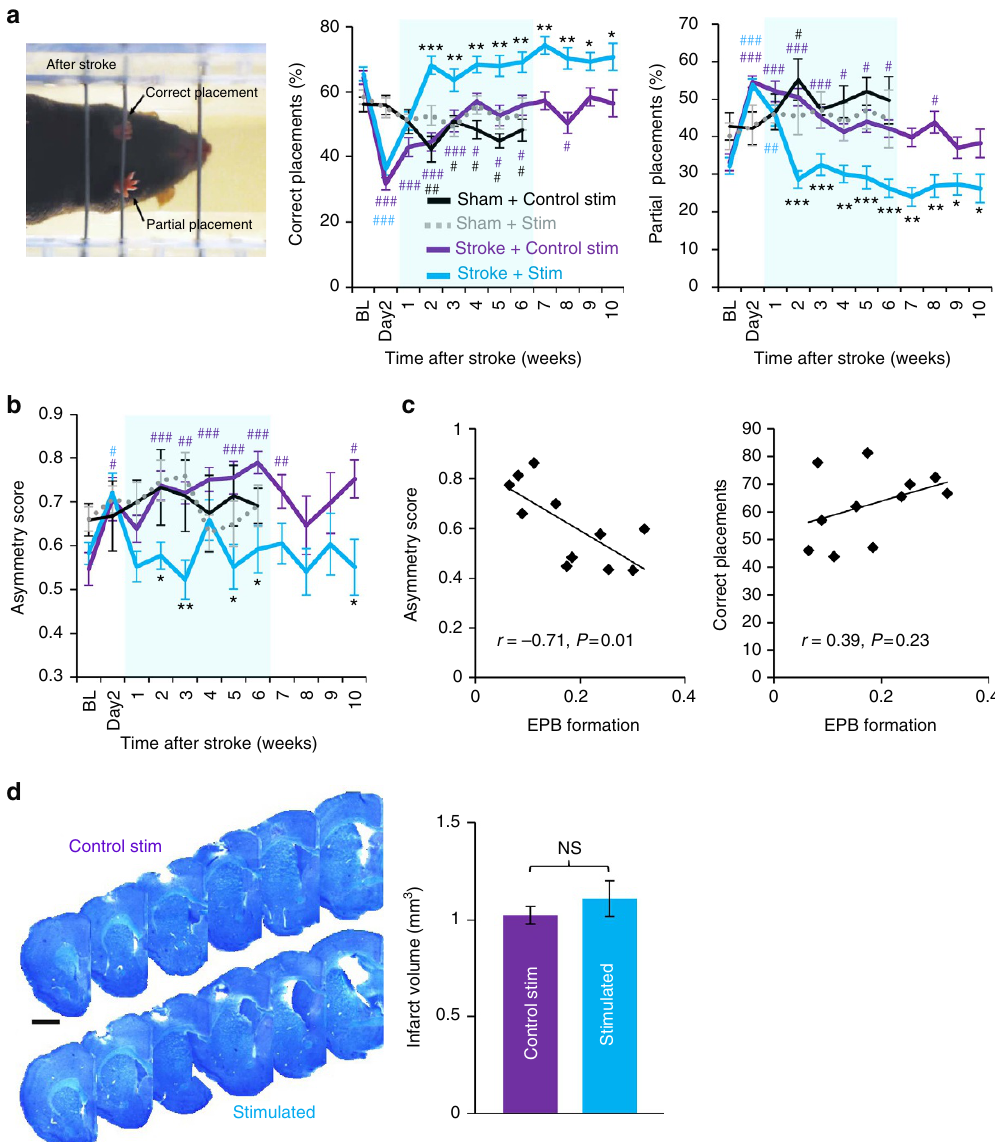
Figure 7 | Recovery of forepaw function is enhanced by optogenetic stimulation. ( a ) Left, image showing a mouse making a partial placement with the stroke-affected paw and a correct forepaw placement with the good limb. Centre and right, graphs showing the percentage of total placements (of the stroke affected forepaw) that were classified as either ‘correct’ or ‘partial’ in sham stroke controls (Control stimulation: n ¼ 5 mice; ChR2 stimulation: n ¼ 6 mice) and stroke affected mice that received control or optogenetic stimulation ( n ¼ 8 mice for each stroke group). ( b ) Graph shows asymmetry in tape removal latency (scores 4 0.5 indicate more time spent removing tape from stroke affected paw) in each group ( c ) Scatter plots showing the correlation between EPB formation rates at 2 or 3 weeks recovery with their respective scores on tape and ladder tests. ( d ) Representative montages of cresyl violet stained coronal sections showing the anterior to posterior extent of focal photothrombotic stroke. Right, analysis of infarct volume in each group ( n ¼ 6 mice per group, P ¼ 0.21 based on t -test). Data are means ± s.e.m. # P o 0.05, ## P o 0.01, ### P o 0.001 based on t -tests comparing post-stroke time points in each group designated by colour to respective BL values. * P o 0.05, ** P o 0.01, *** P o 0.001 based on t -tests comparing stroke þ stimulation versus stroke þ control stimulation. Scale bar, ( d ) and fewer partial placements than stroke-affected mice given All stroke-affected mice showed a deficit 2 days following stroke control stimulation (Fig. 7a; P o 0.001 group (cid:3) time interaction (Fig. 7b), but only stimulated mice showed a normalization of based on two-way ANOVA for both correct and partial forelimb preference/use over time relative to control-stimulated placements). The tape removal test assesses forepaw use mice (Fig. 7b; P o 0.05 group (cid:3) time interaction based on two- asymmetry 49 by determining whether the time to remove a way ANOVA). Notably, behavioural improvements persisted piece of tape from each paw is equivalent (ratio of 0.5) or if there after therapy ceased ( 4 6 weeks). Furthermore, there was a is a bias towards one paw or the other (ratio 4 0.5 indicates more significant correlation between EPB formation rates at 2–3 weeks time to remove tape from the stroke-affected paw). Both sham recovery with performance on the tape test and a trend towards stroke control groups did not show any significant changes over better performance on the ladder test (Fig. 7c), suggesting that time (Fig. 7b; P 4 0.05 for main effect of time based on ANOVA). structural growth is associated with functional improvements.